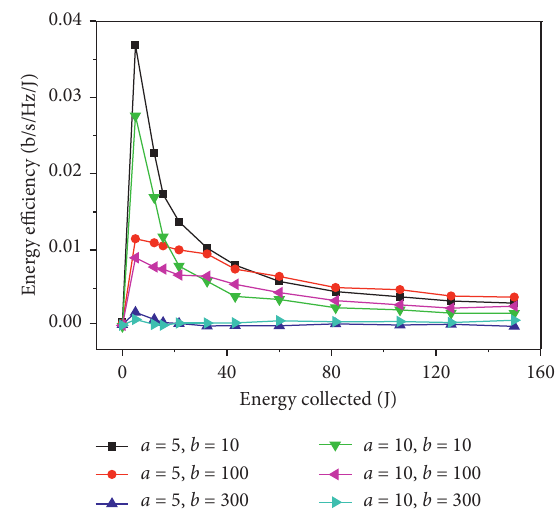
Figure 6: The IoT energy efficiency results achieved by the pro- posed scheme when ρ � 0.1.